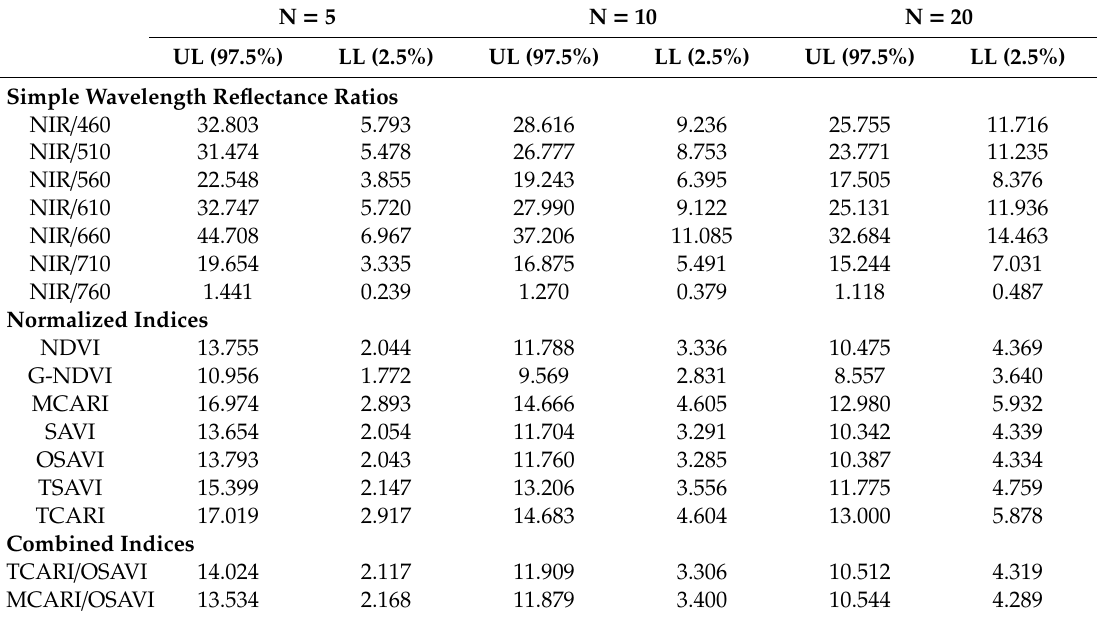
Table 7. Experiment 5#. Coe ffi cient of variation (CV%) limits (P = 95%) with di ff erent number of observations per measurement (N = 5, N = 10, and N = 20), generated with bootstrap analysis by using SET WHOLE data (see Section 2.3 data analysis). LL, lower limit at P = 2.5%; UL, upper limit